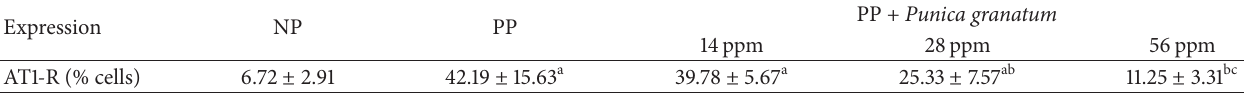
Table 1: Level of Angiotensin-II Type I receptor in endothelial cells induced by plasma preeclamptic patients. Expression